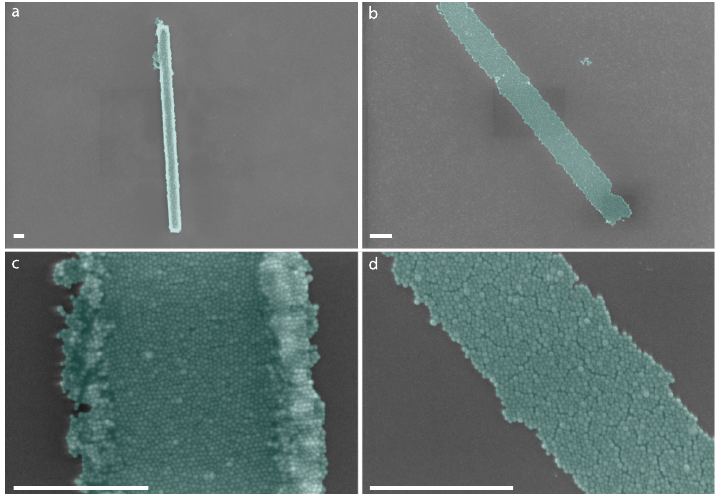
Figure 11. Clearing the borderline of nanoparticles assembly. ( a – d ), False color SEM images of patterned rectangles of magnetic nanoparticles. Panel ( c ) is the magnified image of an area in panel ( a ). Panel ( d ) is the magnified image of an area in panel ( b ). All scale bars are 500